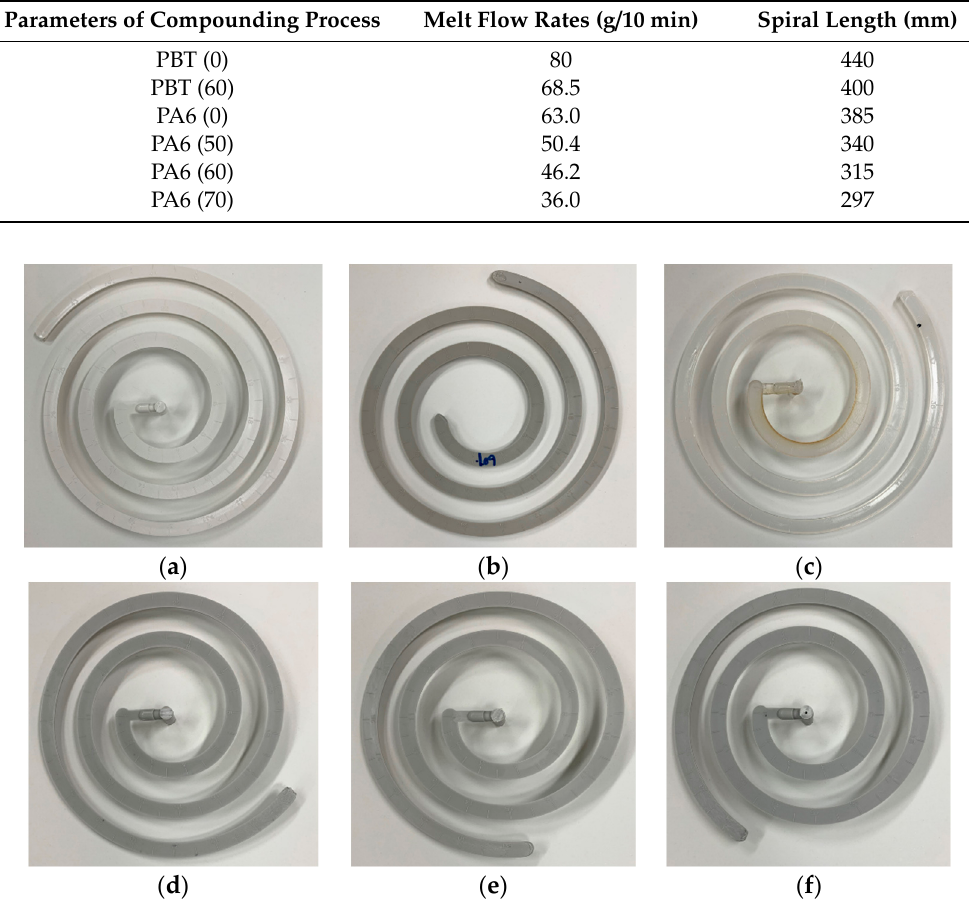
Figure 1. Spiral lengths of the PBT and PA6 compounds according to the Al 2 O 3 content (a) PBT (0): 440 mm, (b) PBT (60): 400 mm, (c) PA6 (0): 385 mm, (d) PA6 (50): 340 mm, (e) PA6 (60): 315 mm, (f) PA6 (70): 297 mm.